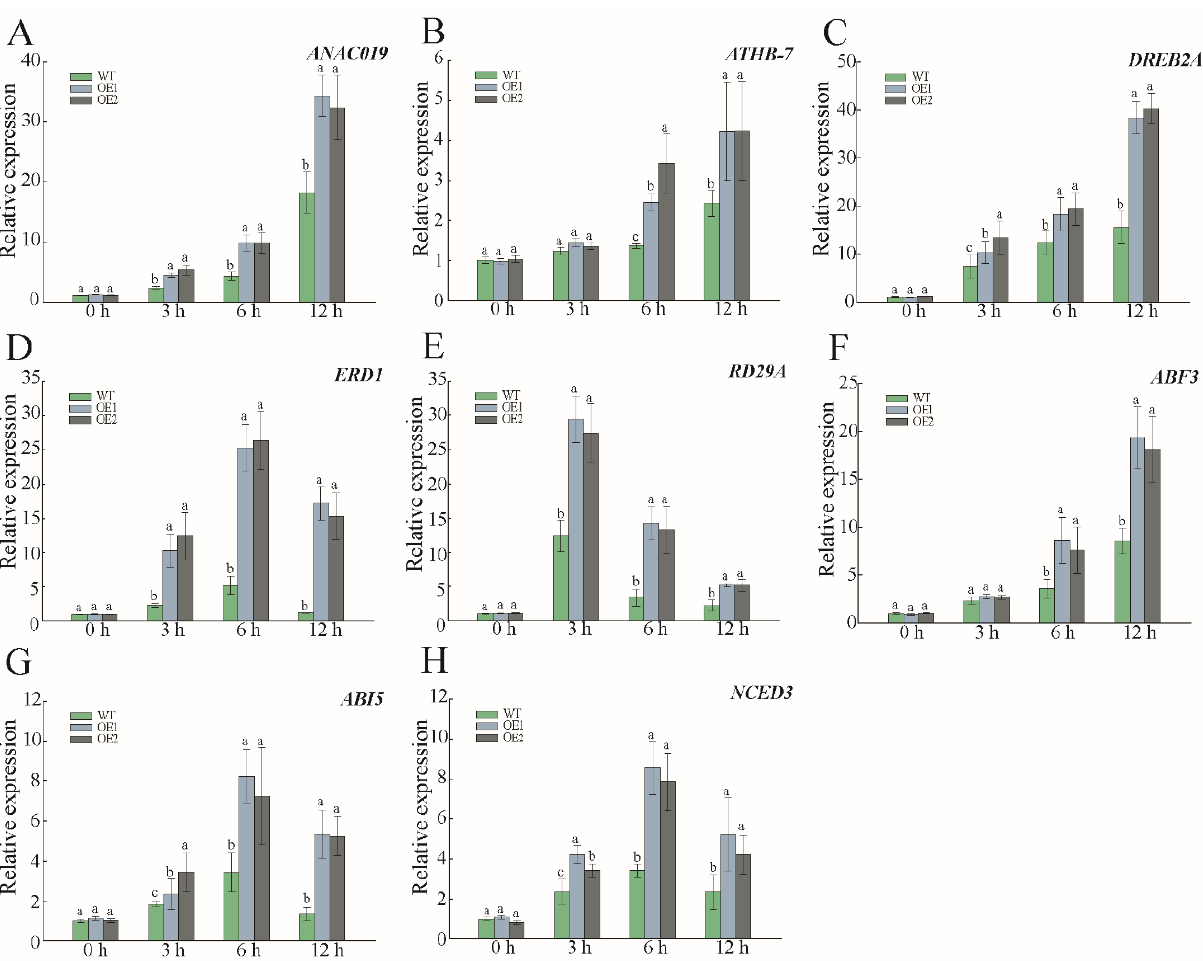
Figure 11. Relative expression of downstream genes in WT and PwNAC38 transgenic lines under simulated drought stress by qRT-PCR. ( A – E ) Expression patterns of some drought responsive genes. ( F – H ) Expression patterns of some ABA responsive genes. The significantly different mean values at p ≤ 0.05 were labeled by different letters.